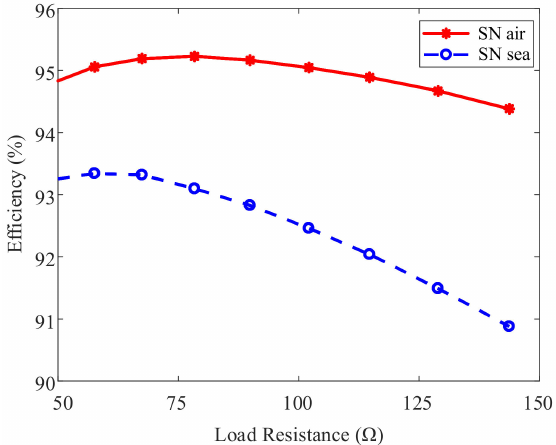
Figure 12. System efficiency varying with the load